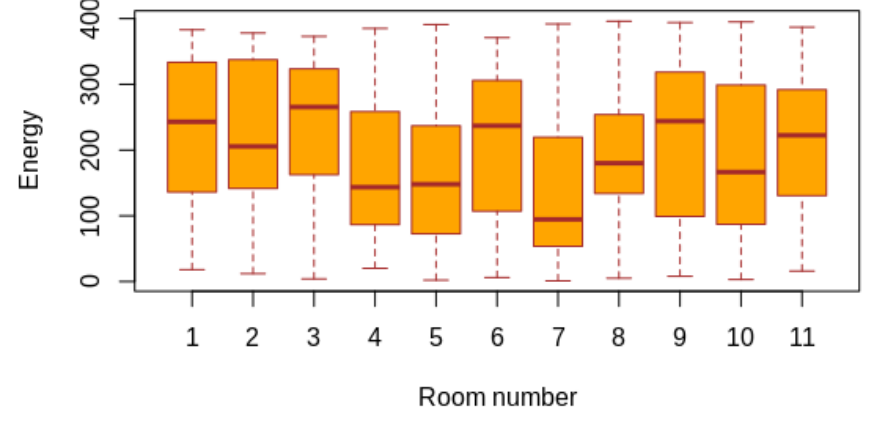
Figure 5. Energy distribution per room.